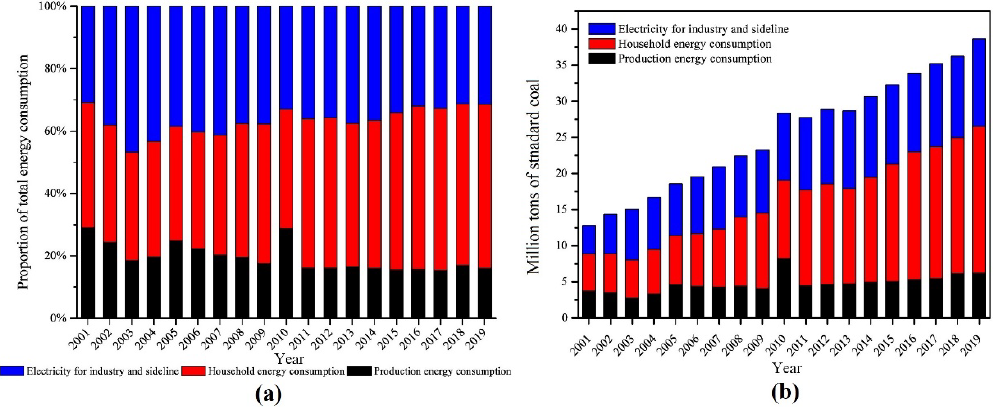
Figure 2. Energy consumption structure in the rural areas of Guangdong. ( a ) Energy consumption composition and proportion; ( b ) Energy consumption amount. From Guangdong Rural Statistical